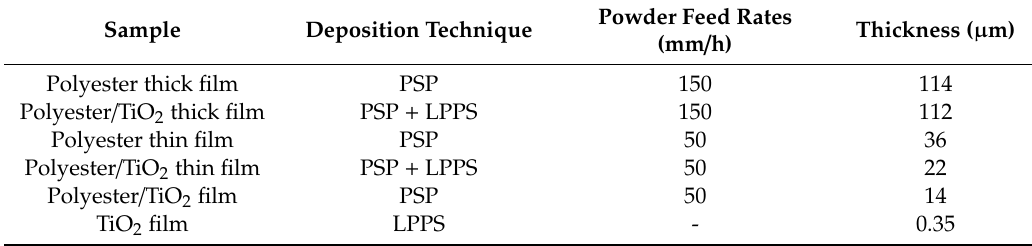
Table 2. Average thicknesses of the